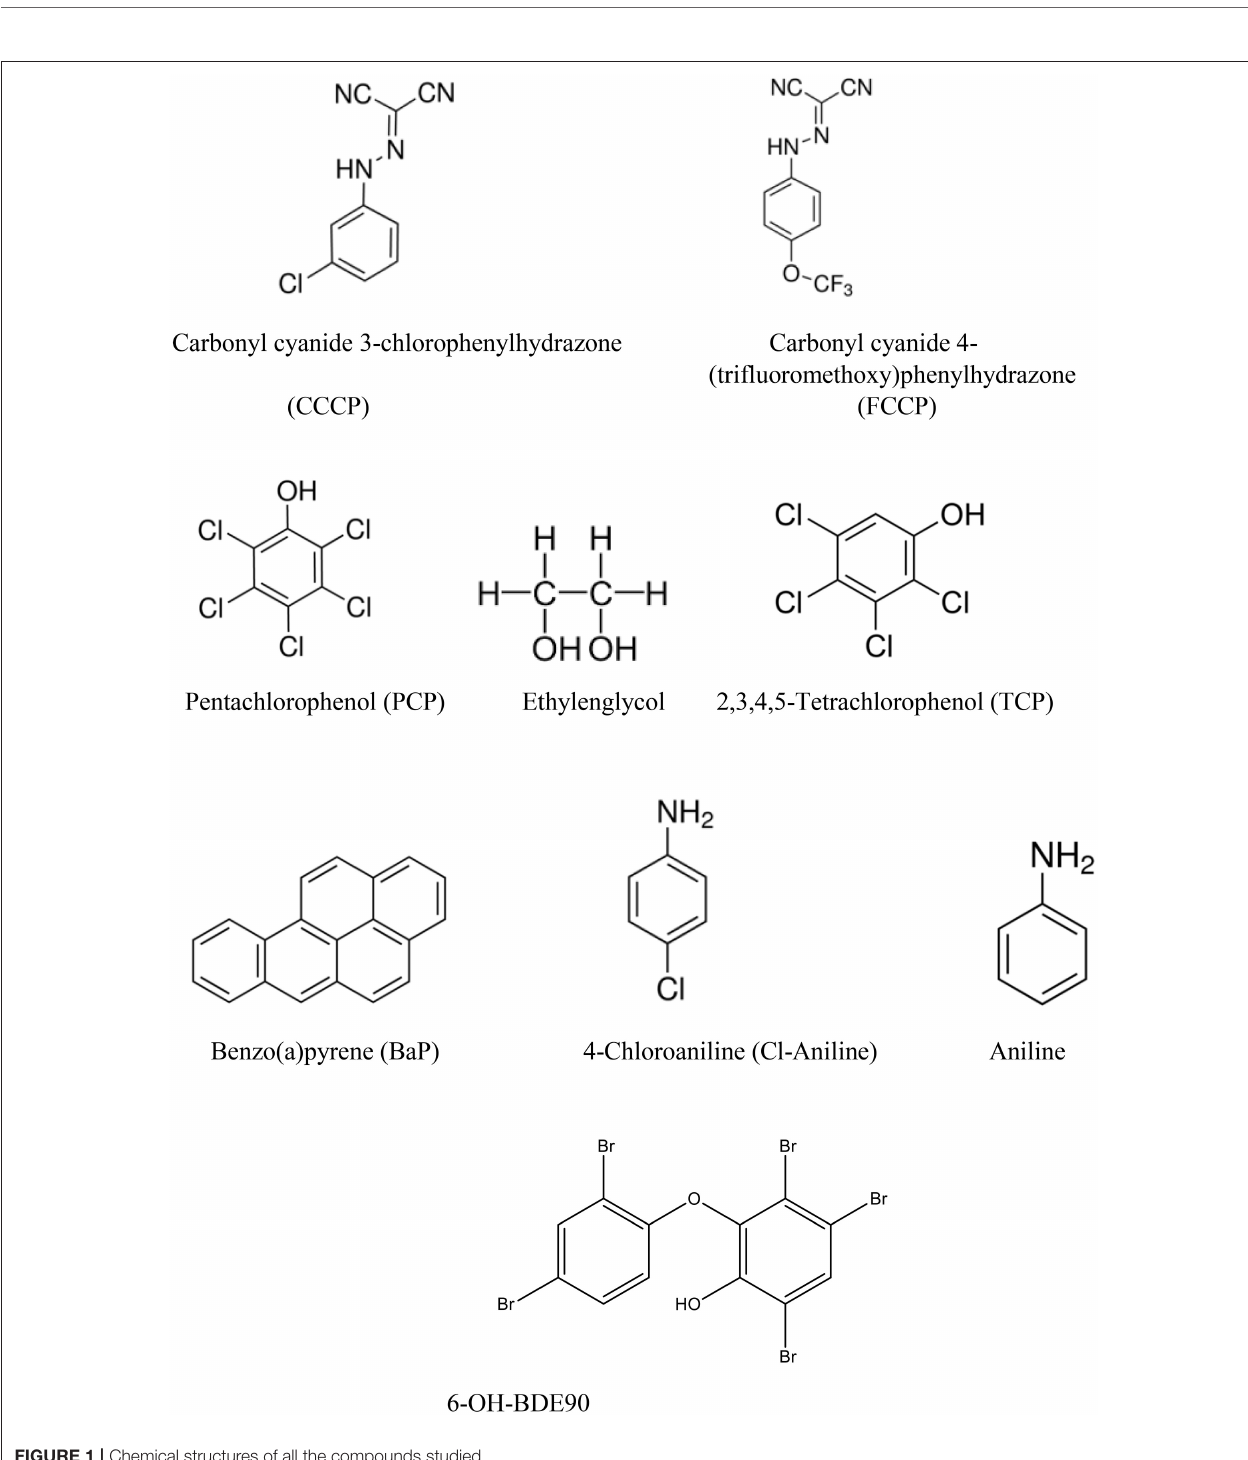
Microarray Experiment C3A cells were exposed for 2 h to substances as described above for the TMRM assay. For microarray analysis, six replicate wells per concentration were pooled. DMSO (0.1%) was used as solvent control. The concentrations used for the exposure were: